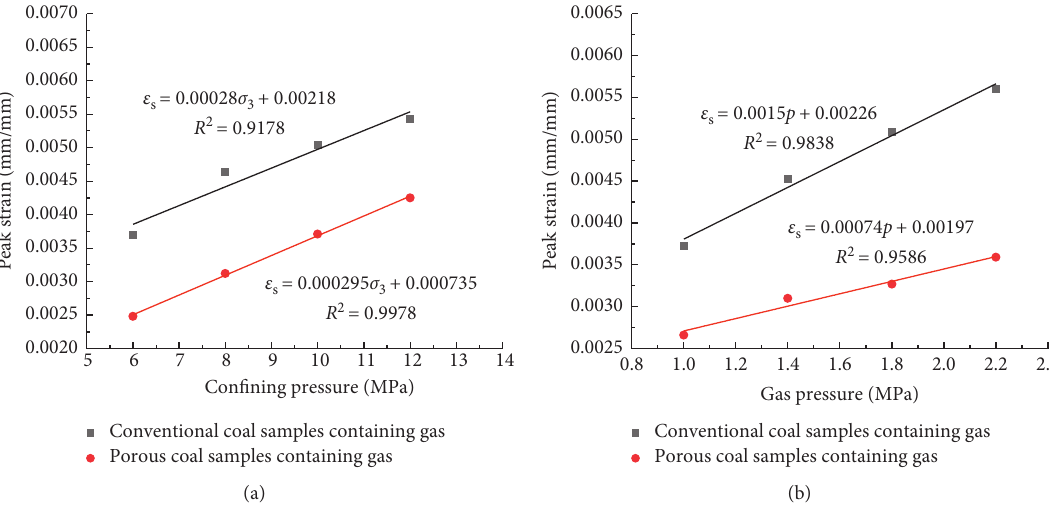
Figure 3: Variation of peak strain of porous and conventional gas-bearing coal samples with confining pressure or gas pressure: (a) variation with confining pressure; (b) variation with gas pressure